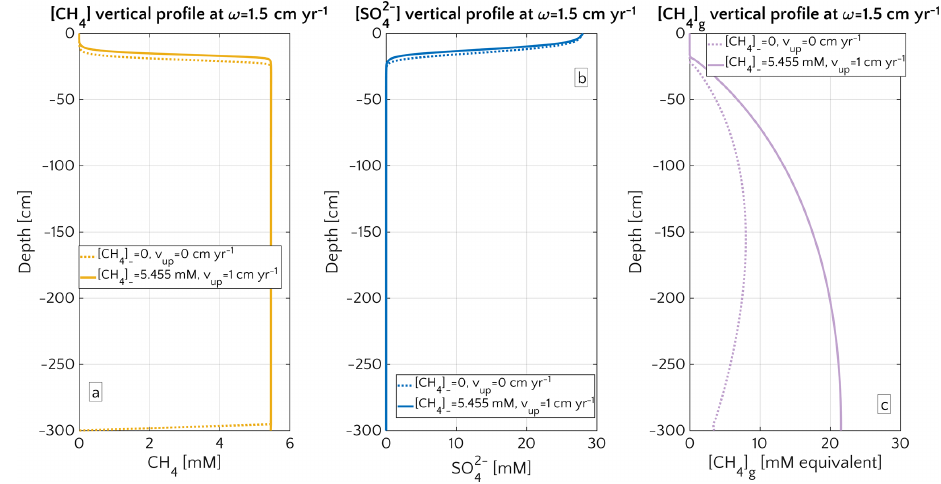
Figure 4. Porewater profiles in the case of ω = 1 . 5cmyr − 1 for CH 4 (a) , SO 2 − passive scenario with [ CH 4 ] − = 0mM, while continuous lines simulations display active scenario with [ CH 4 ] − = 5 . 455mM, corresponding to the saturation concentration in the environmental conditions considered for the representative